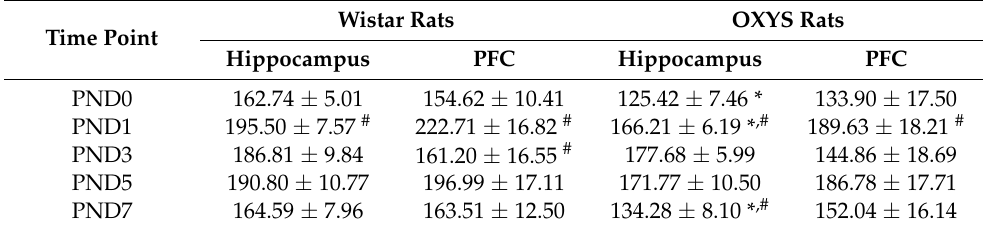
Table 4. The area of microglia in the hippocampus and PFC of OXYS and Wistar pups ( µ m 2 ). Time Point